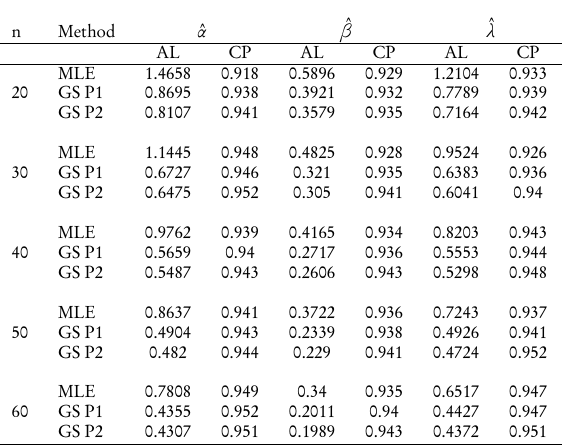
The average length (AL) and coverage probability (CP) of 95% asymptotic confidence / HPD credible intervals of parameters when α = 2, β = 0.5, λ = 1.